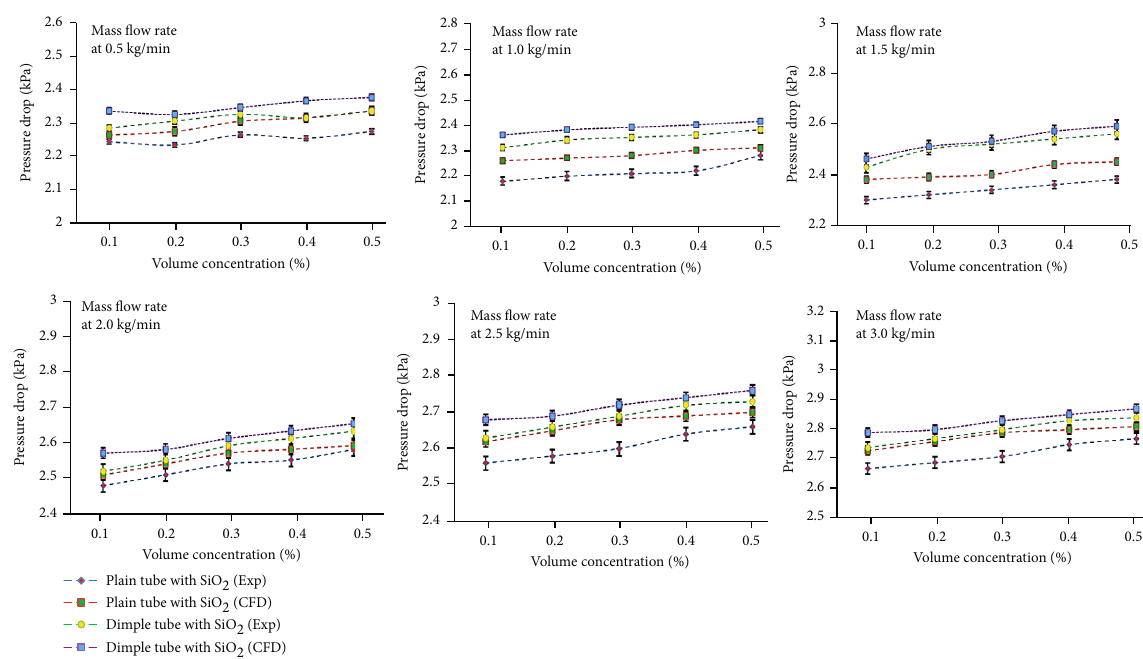
Figure 12: Variation of pressure drop with variation in nanoparticle volume concentration and mass fl ow